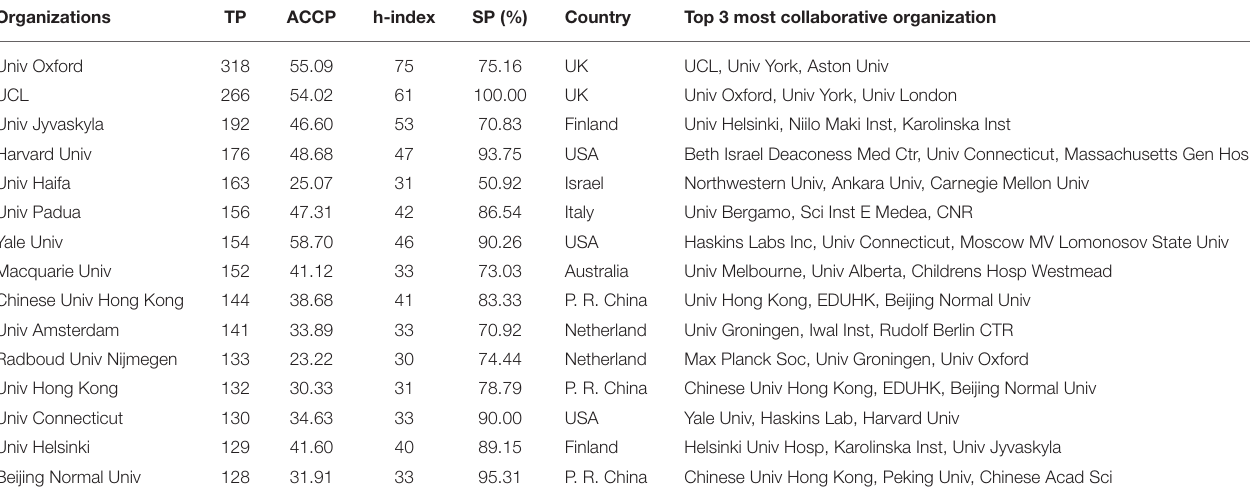
TABLE 1 | The top 15 most productive organizations of publication, citations and h-indices during 2000–2021. Organizations